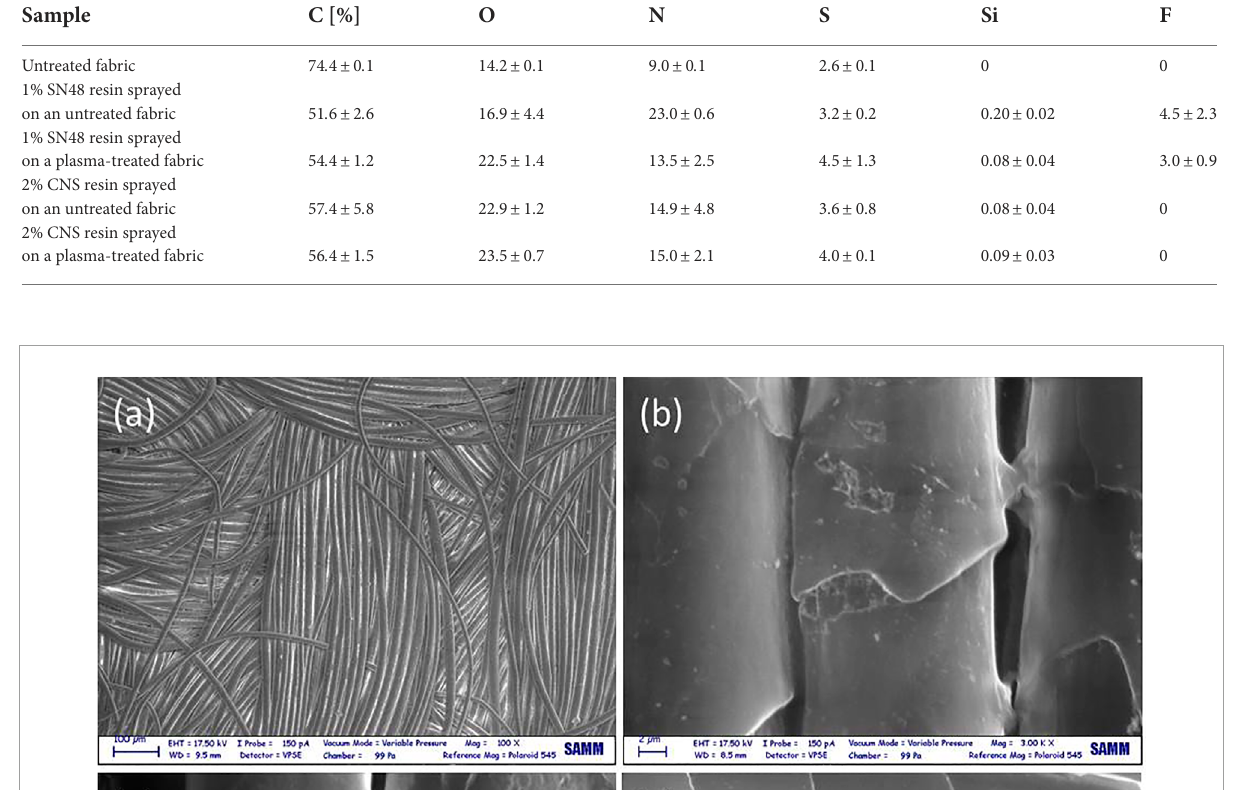
TABLE 3 EDXfibercomposition(in%)measuredonresin-sprayedsamplesofuntreatedvs.plasma-treatedfabricsatthecuticleedges.Theoriginal cashmerecompositionisreportedtoo. Sample